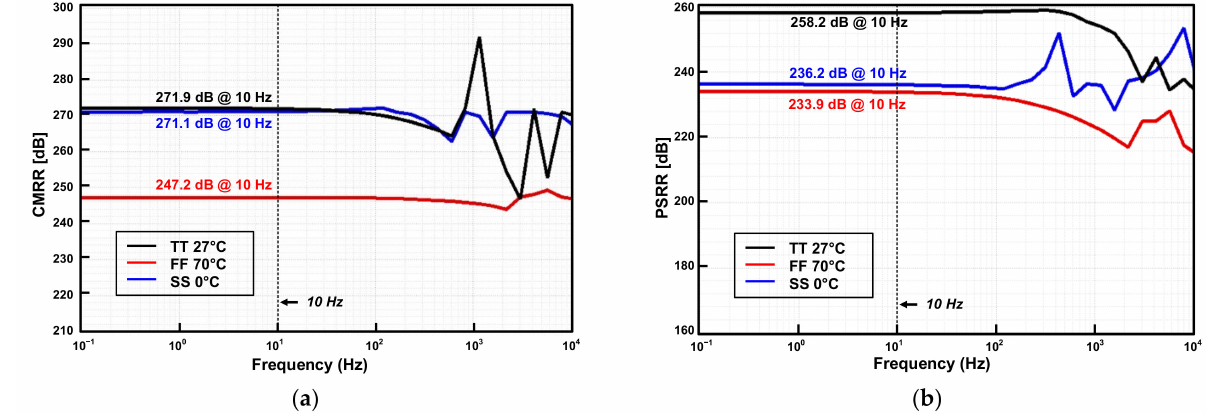
Figure 10. Corner simulation result of the ( a ) CMRR and ( b ) PSRR.